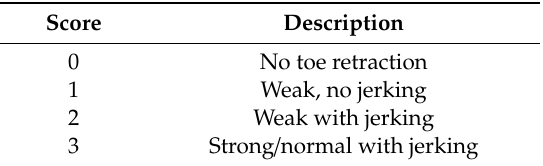
Table 3. Hind limb toe-pinch retraction response score standard.